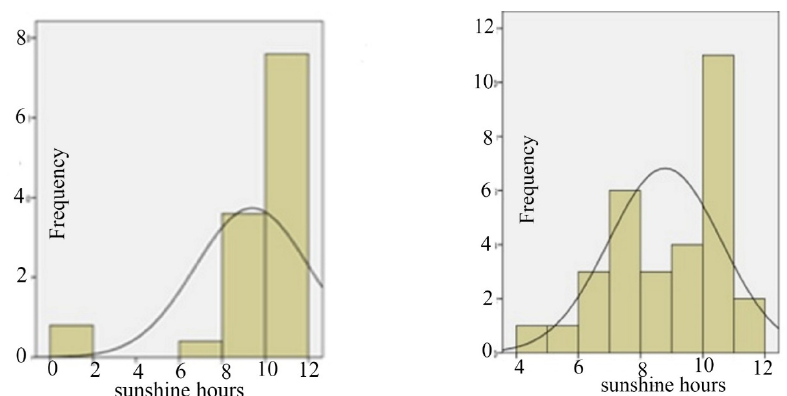
Figure 8. Sunshine hours’ distributions in August 2008 ( Left ) and 2009 ( Right ).